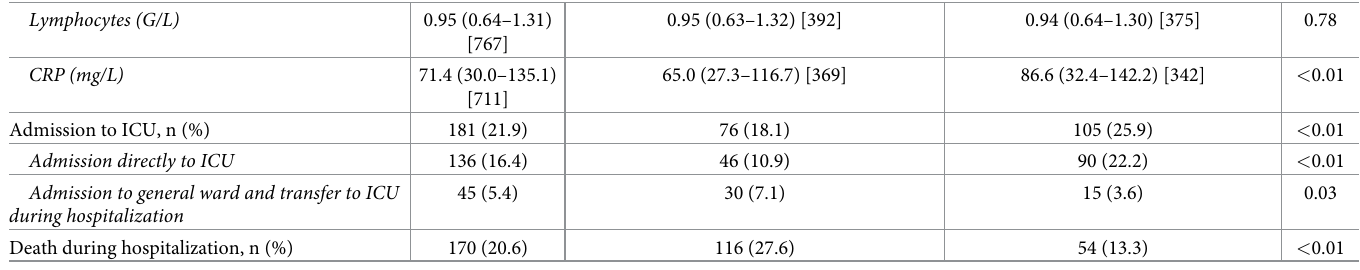
weakness (p = 0.02), shortness of breath (p = 0.01), pain (p < 0.01), ageusia (p < 0.01) and anos- mia (p < 0.01). The frequency of reported confusion was lower in patients with a longer delay (p < 0.01), whereas the plasmatic levels of C-reactive protein (CRP) were significantly higher (p < 0.01) than in patients with a shorter delay. The crude in-hospital fatality rate was lower in the group of patients with a longer delay (13.3%) than in patients with a short delay (27.6%), p <